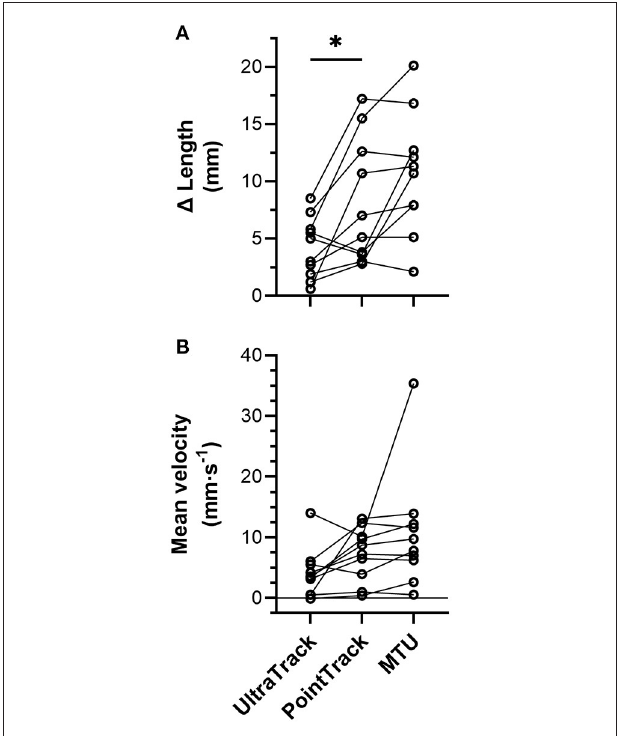
FIGURE 7 | Individual ( n = 10) (A) left-sided biceps femoris long head (BF) muscle fascicle length and muscle-tendon unit (MTU) length change amplitudes and (B) mean velocities over the period when fascicle lengths were tracked from ∼ 85 to 100% of peak force during the Nordic hamstring exercise (NHE). Solid lines link the same participant, and descriptive statistics are reported in the Results section. *Indicates a significant difference between conditions ( p < 0.05).